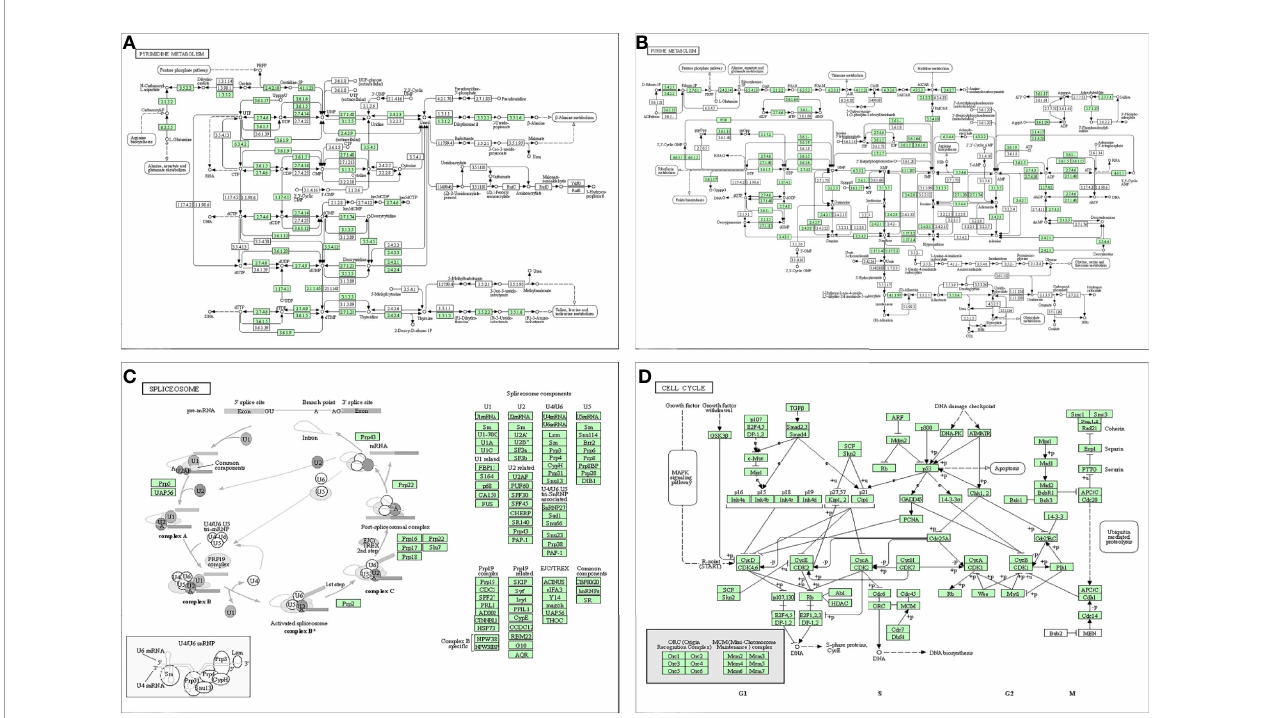
FIGURE 8 | Dissection of heterogeneous nuclear ribonucleoprotein C (HNRNPC)-associated signaling pathways by Gene Set Enrichment Analysis of 188 lung cancer cell lines from the Cancer Cell Line Encyclopedia database (CCLE). (A) pyrimidine metabolism. (B) purine metabolism. (C) spliceosome. (D) cell